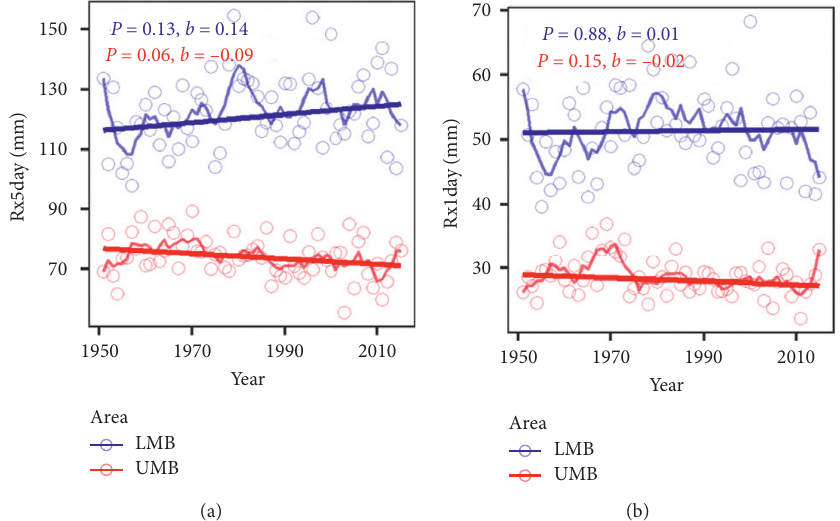
Figure 7: Temporal trends in Rx5day and Rx1day averaged across the UMB and the LMB over 1951–2015. The lines represent linear trends of precipitation indices, and the polylines indicate the five-year moving averages of the indices.